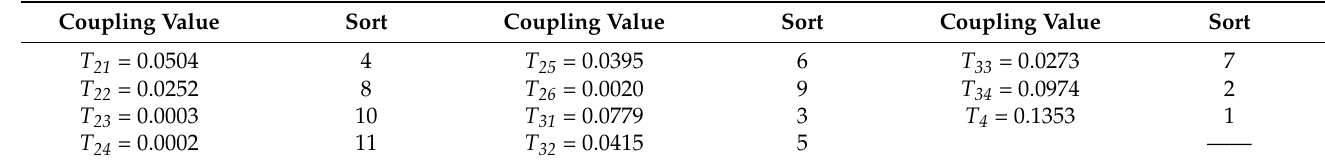
Table 8. Risk Coupling Values of Marine Accidents.